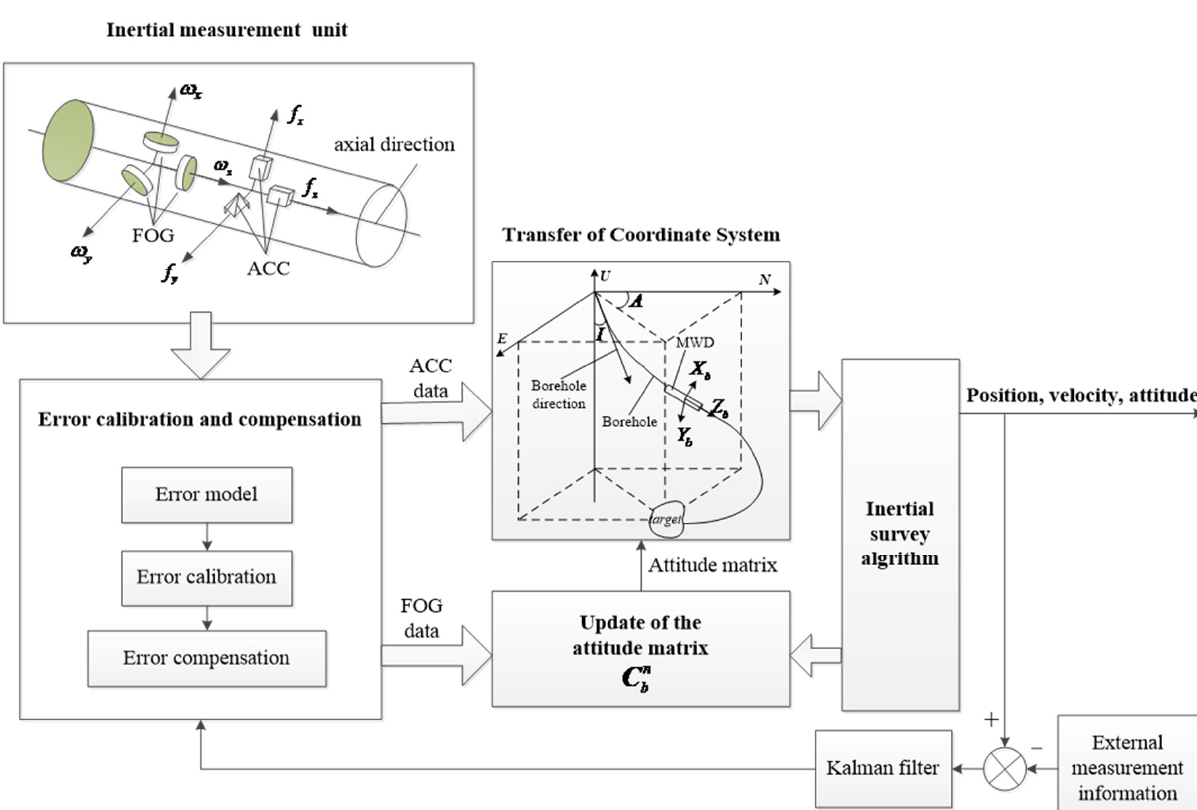
Figure 2. Flow chart of the FOG-based MWD measurement algorithm. Firstly, the carrier angular velocity (cid:101) ω b is measured by the FOGs in b-frame. The ib b carrier acceleration (cid:101) f is measured by the ACCs in b-frame. Secondly, the errors in the ib original sensor data should be compensated. ω b and f b stands for the data whose error ib ib has been compensated. Thirdly, the attitude matrix C l is updated by using angular velocity b ω b . Fourthly, ω b and f b are transferred from b-frame into the l-frame by the updated ib ib ib attitude matrix C l . The C l is described in (1) b b